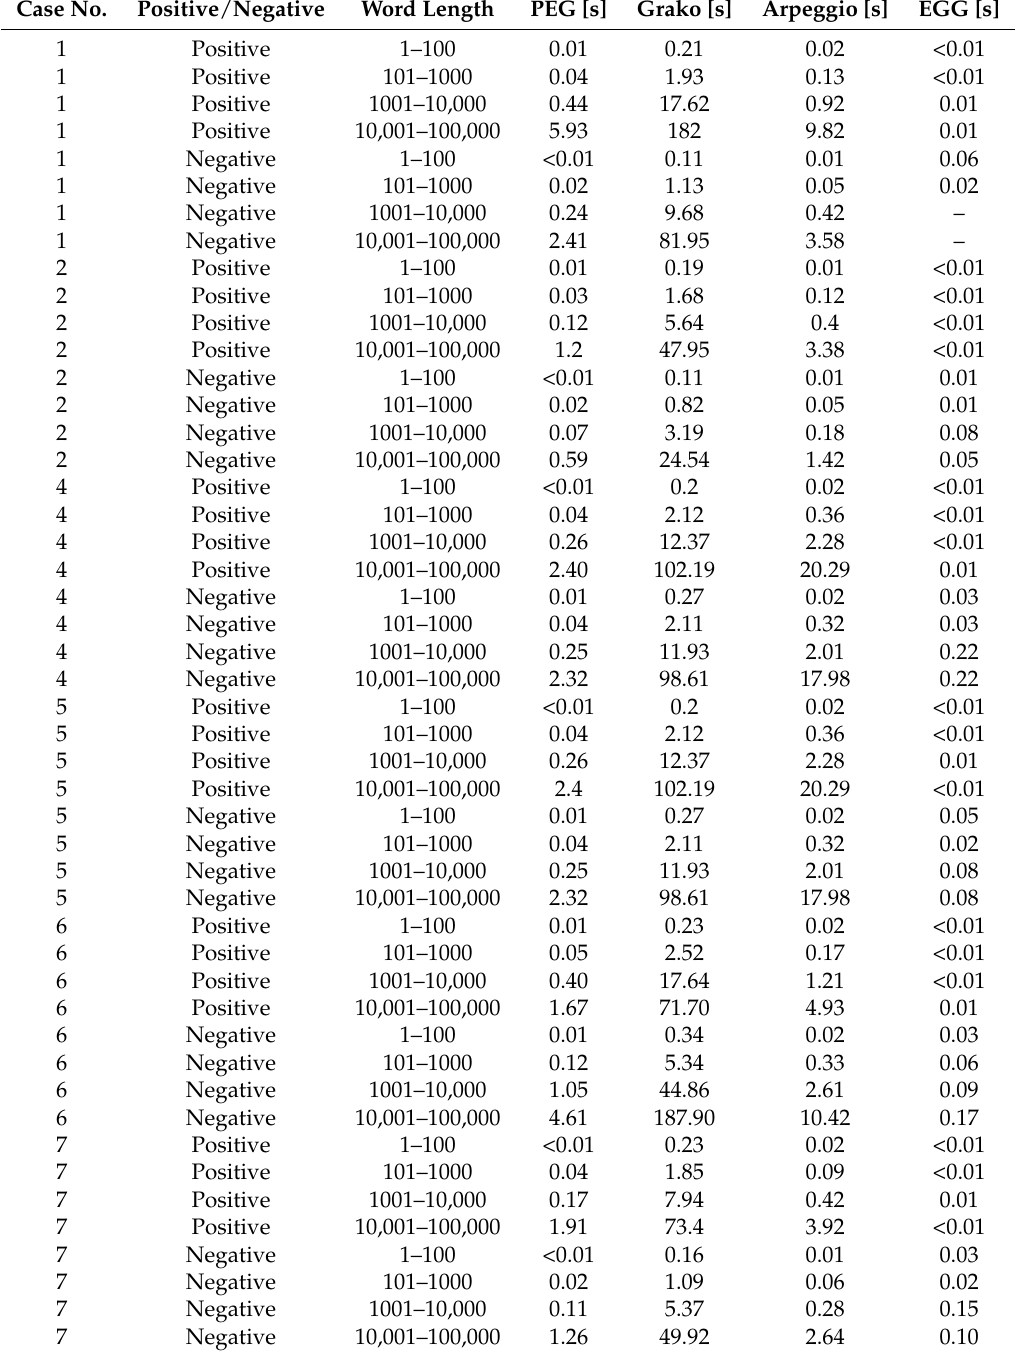
Table 3. Average CPU times for available Python PEG libraries (in